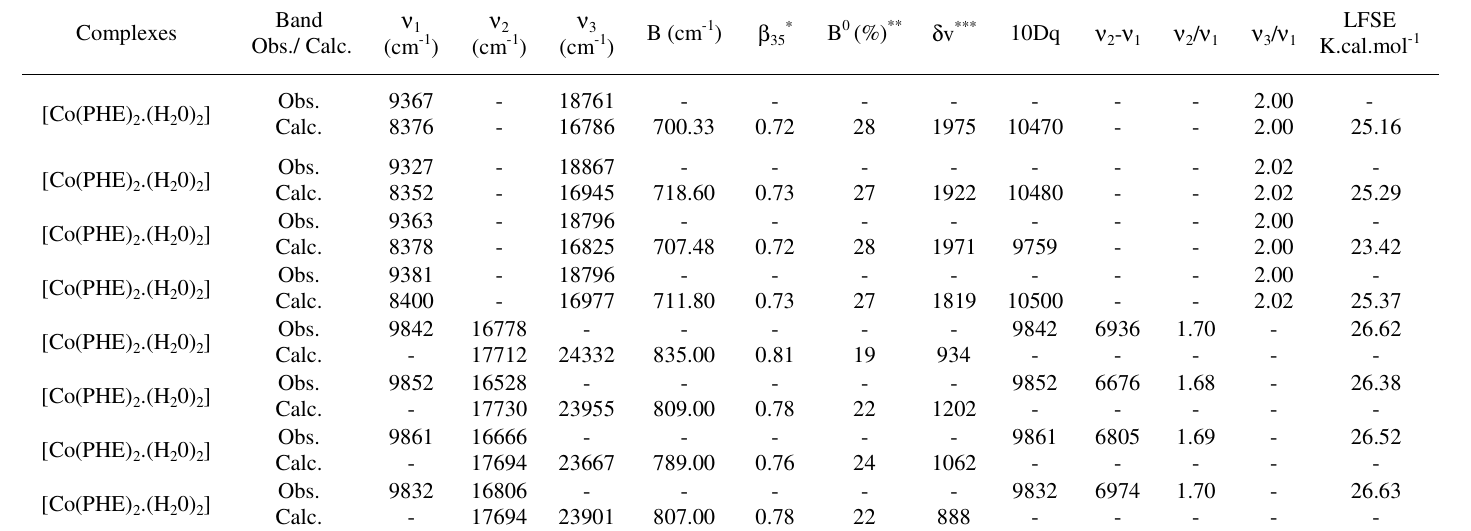
Table 3 . Electronic spectral data and ligandss field parameters of Co II and Ni II hydrazone complexes